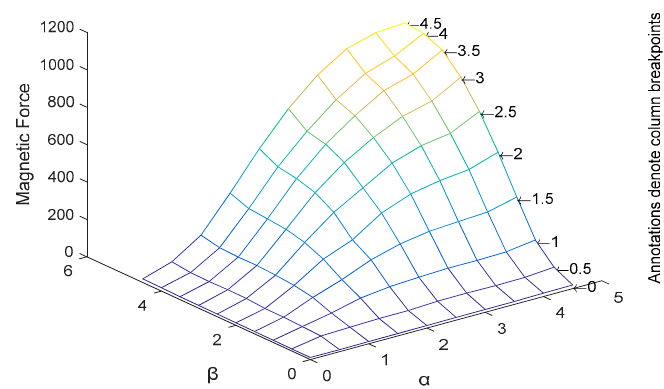
Figure 4. Experimental data of the cycles.